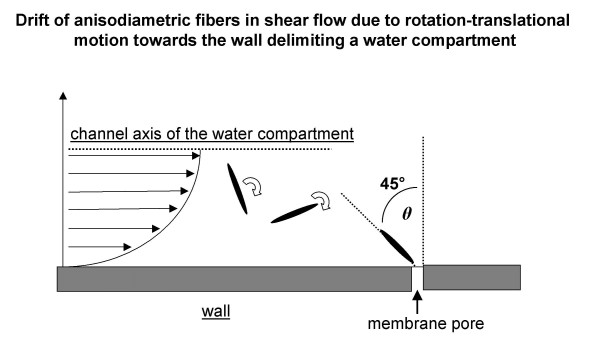
Continuous rotation, tumbling and oscillation result in drift of anisodiametric particles towards the wall delimiting the compartment (e.g. endothelial membrane). At the shear rate close to the wall, the lowest rotational velocity is attained at an angle θ of 45° relative to the wall; thus, a particle being driven by convective flow has a greater probability to hit the wall at this angle.